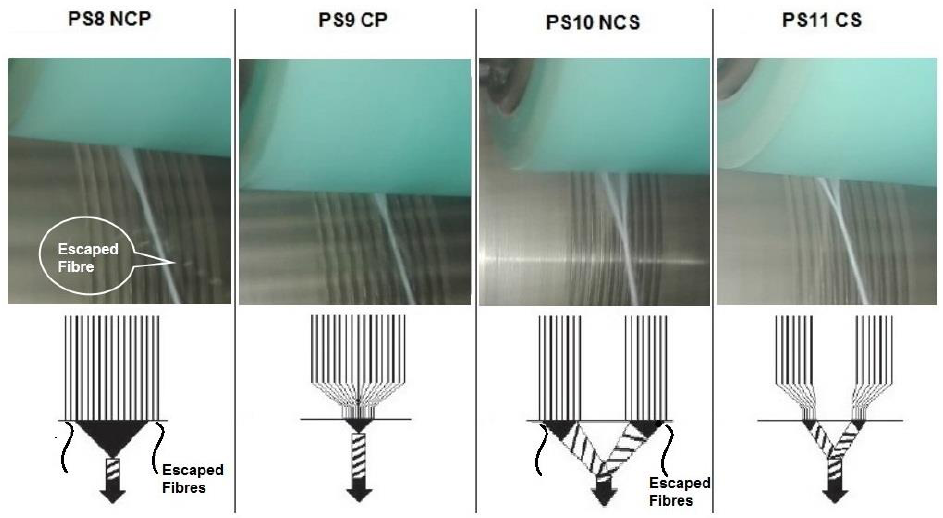
Figure 6. Yarn formation zone of plain and SIRO, compact and noncompact yarns.